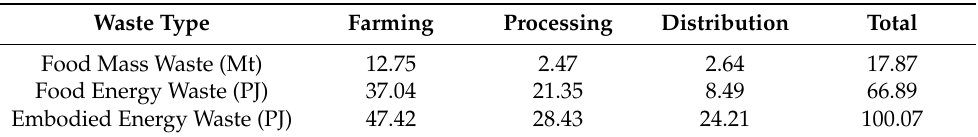
Table 6. Food Mass Waste (FMW), Food Energy Waste (FEW) and Embodied Energy Waste (EEW) for the different steps of the FSC, year